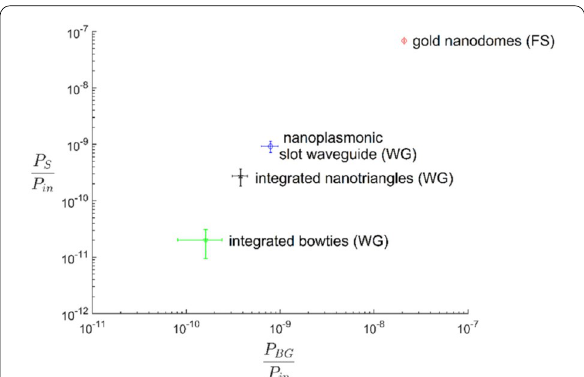
Fig. 13 Comparison of SERS background power P BG (x-axis) and SERS Stokes power P S (y-axis) of different SERS platforms. Both parameters are normalized on the input power and the integration time. FS indicates free-space and WG is the waveguide-based excitation. (Reprinted with permission from Ref.